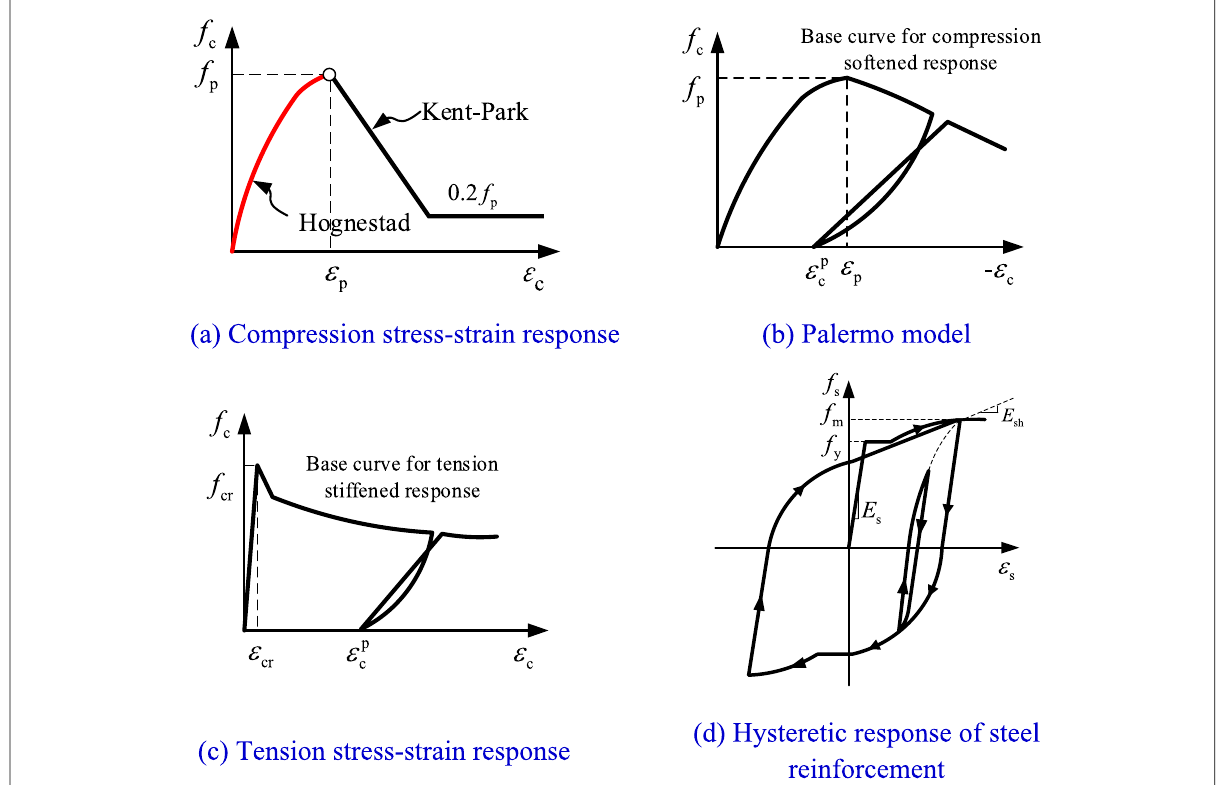
Fig. 3 Material constitutive models used in the RC wall